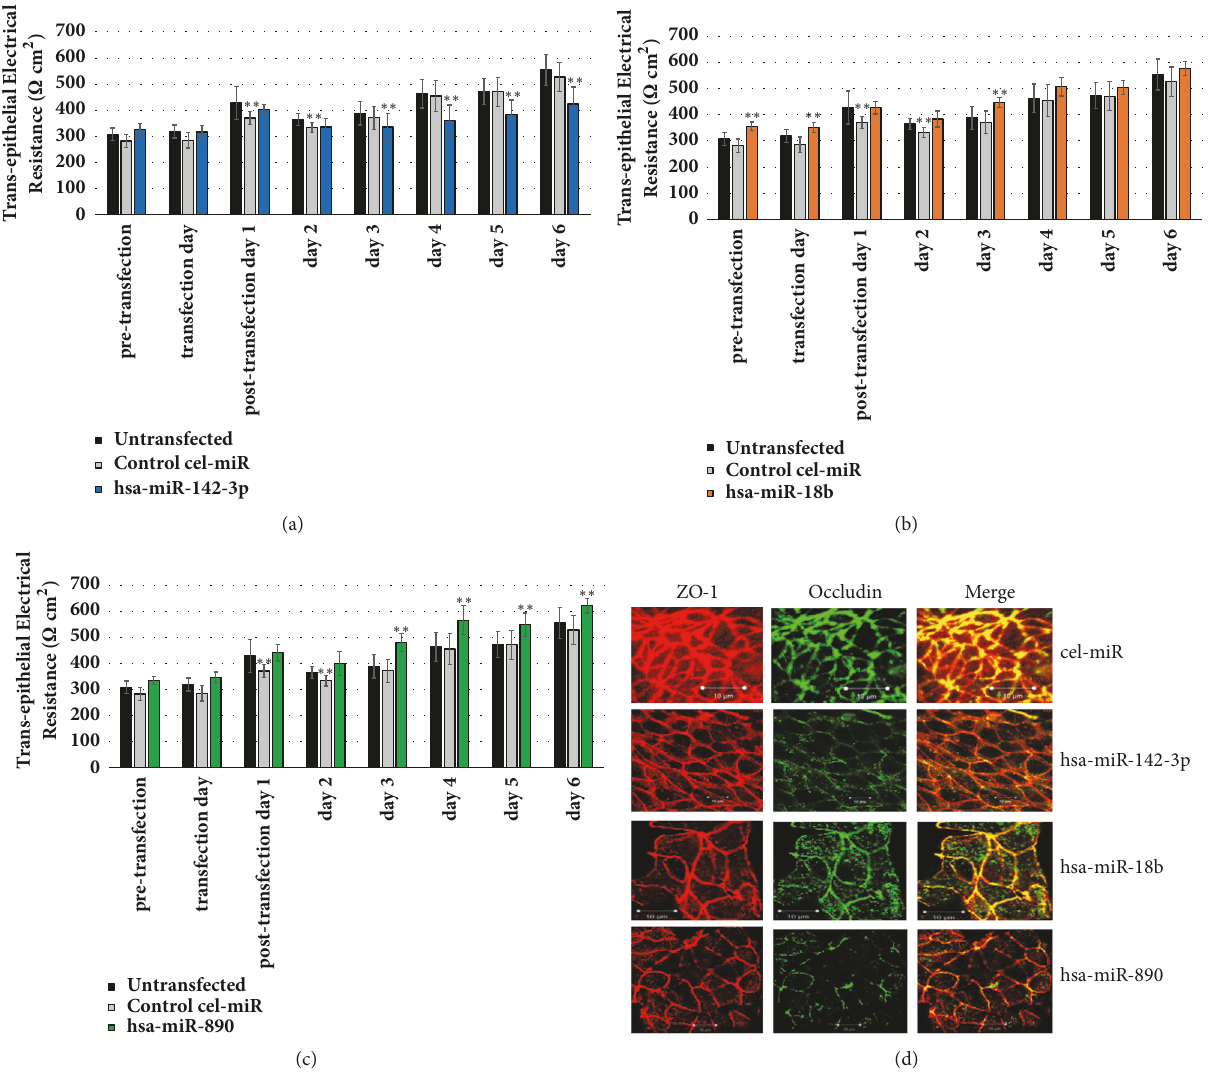
Figure 2: Transfection of MetS-FL miR mimics into Caco-2colon epithelial monolayers leads to miR-specific changes in barrier integrity and epithelial cell junction. (a, b, c) Transepithelial electrical resistance (TEER) was measured daily pre- and posttransfection of cells with control miR mimic or MetS-FL miR mimics. Background TEER measurements in “blank” wells without cells were subtracted from TEER values in transfected cells. The subtracted TEER values are normalized against seeding surface area and expressed as Ohm-cm 2 . Data are means ± standard deviations calculatedfrom atleastfour biological replicates.Bar graphs show TEER valuesof untransfectedcellsand cellstransfected with control C.elegans cel-miR-67 mimic or each of the MetS-FL miR mimics. ∗∗ indicates significant (p < 0.05) changes in barrier TEER in miR mimic-transfected compared to nontransfected cells. (d) Transfection of MetS-FL miR mimics into Caco-2 colon epithelial monolayers leads to altered appearance of Zona Occludens-1 (ZO-1) and Occludin within the cell junction. Images show immunofluorescence staining and confocal microscopy visualization of ZO-1 (red), Occludin (green), or both (yellow). Scale bars are 10 𝜇